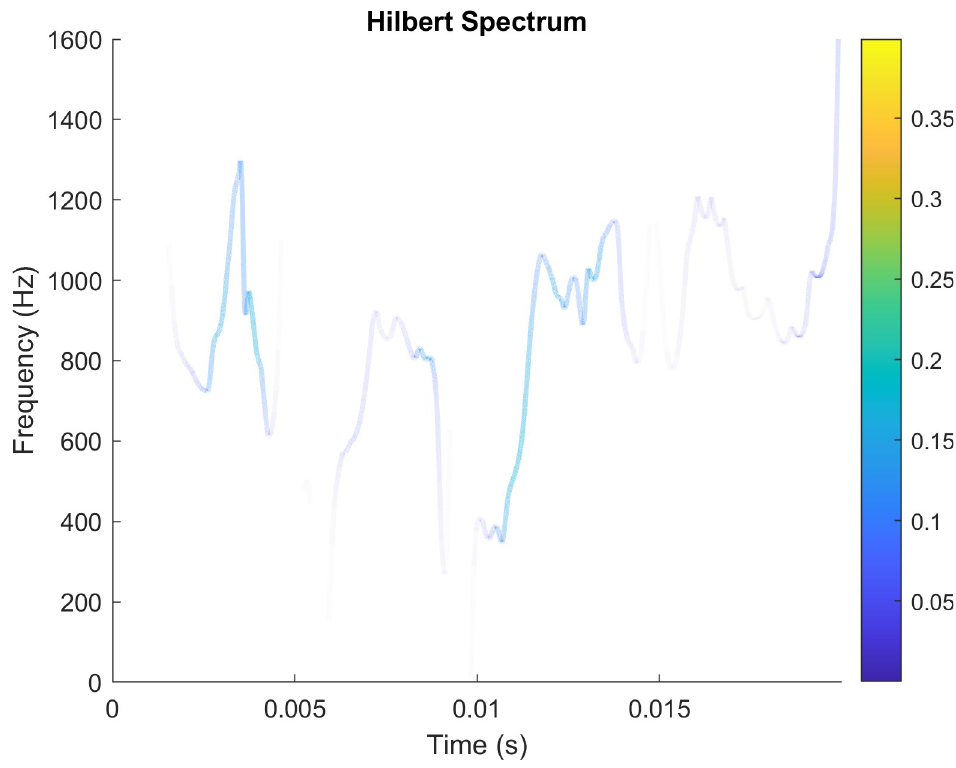
Fig 8. Hilbert spectrum of